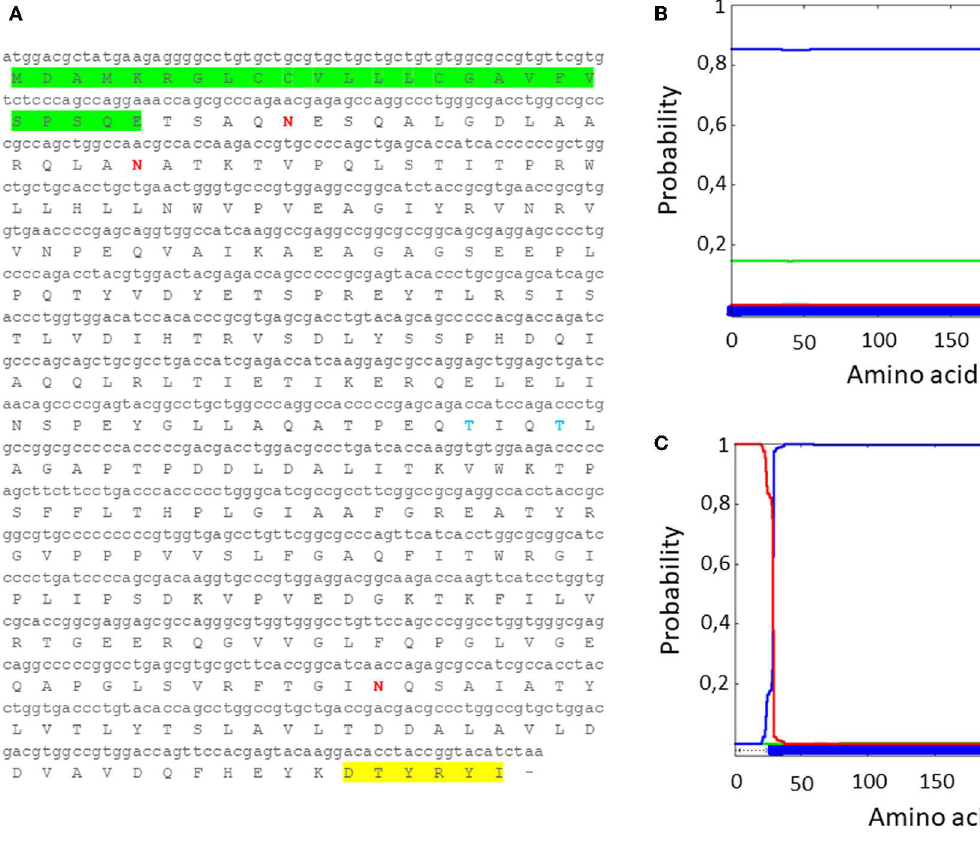
FIGURE 1 | (A) MMP nucleotide sequence with human tPA signal peptide (green), along with the deduced amino acid sequence (tPA-MMP). The AU1 tag is highlighted in yellow. (B) Server output prediction of transmembrane topology and signal peptides from the amino acid sequence of MMP protein compared with (C) MMP amino acid sequence with the human tPA signal peptide (tPA-MMP). In tPA-MMP (C) , but not MMP (B) , a signal peptide is detected and the protein is predicted to be secreted, reaching the top score of probability